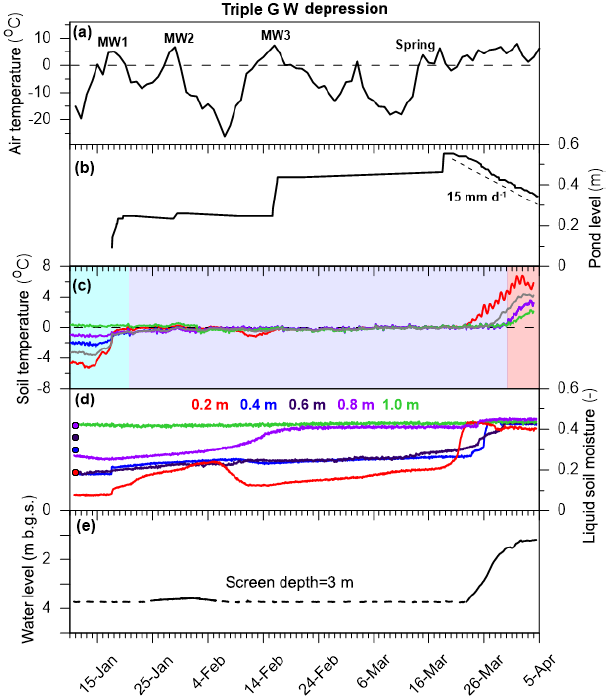
Figure 5. Temporal variability of hydrologic variables during the monitoring period for depression W at Triple G showing (a) the av- erage daily temperature and the identification of snowmelt events; (b) the depression pond level measured on snow gauges using time- lapse cameras and the dashed line indicating the recession rate dur- ing the Spring snowmelt event; (c) soil temperatures; (d) liquid soil moisture, with pre-freezing values shown as circles; and (e) the groundwater level measured in piezometers with the screen depth indicating the midpoint of the screen interval. In panel (b) , blue shading indicates frozen ground, purple indicates partially frozen ground, and red indicates unfrozen